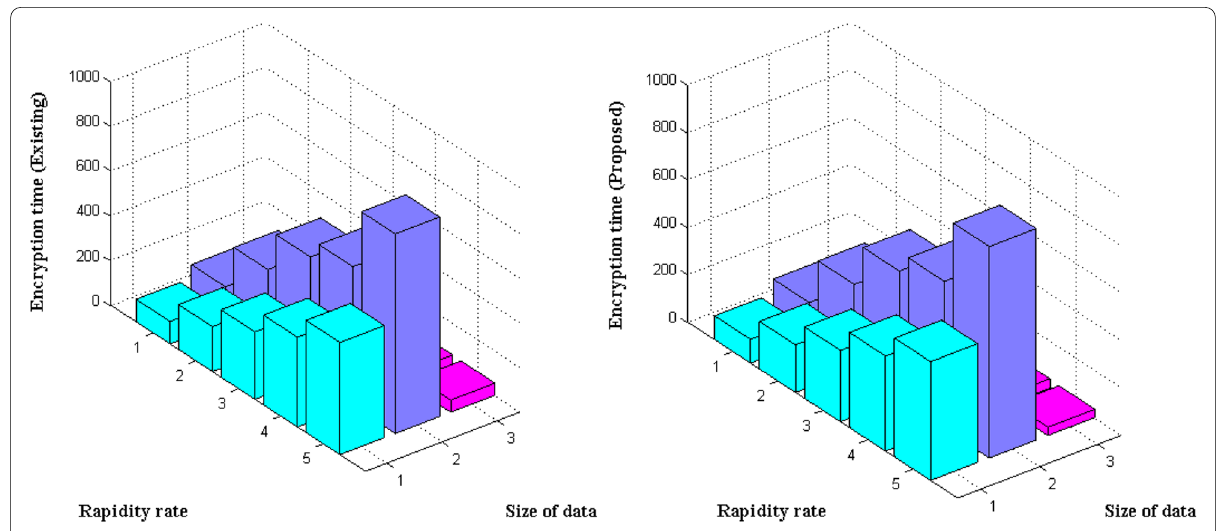
Fig. 7 Encryption time period of data